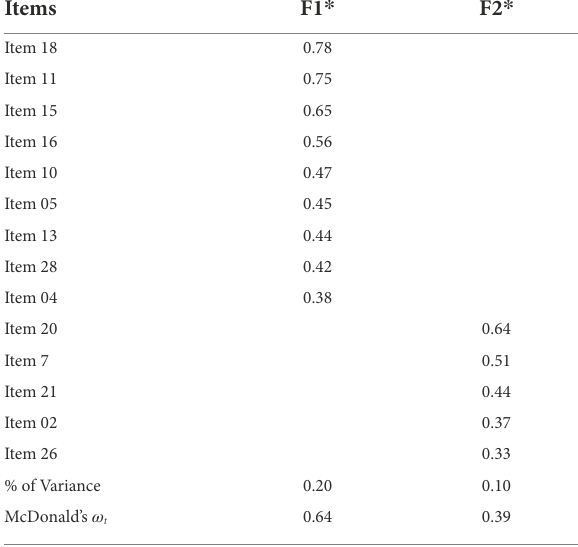
TABLE 2 Factor loadings of two-factor solution from study 1 ( N =